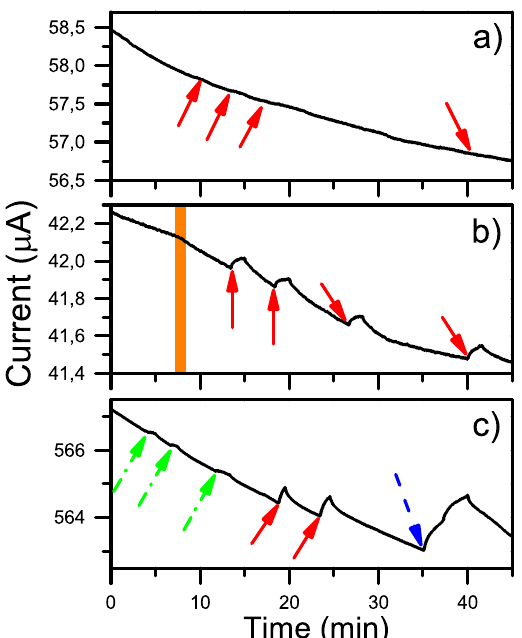
Figure 8. Photoactivity investigation of amphetamine first anchored by and then eluted from antibody coated beads (including exponentially decreasing baselines). ( a ) Only PBS (no analyte) pumped through the system at 50 mV bias; ( b ) amphetamine diluted in PBS pumped through the system at 50 mV bias. The orange marking corresponds to a shift from only PBS to amphetamine in PBS; ( c ) amphetamine diluted in PBS pumped through the system at 500 mV bias. The arrows correspond to the color temperature setting of the microscope lamp: green (dash and dot) = fluorescent ceiling light, red (fully drawn) = 2600 K and blue (dash) = 3000